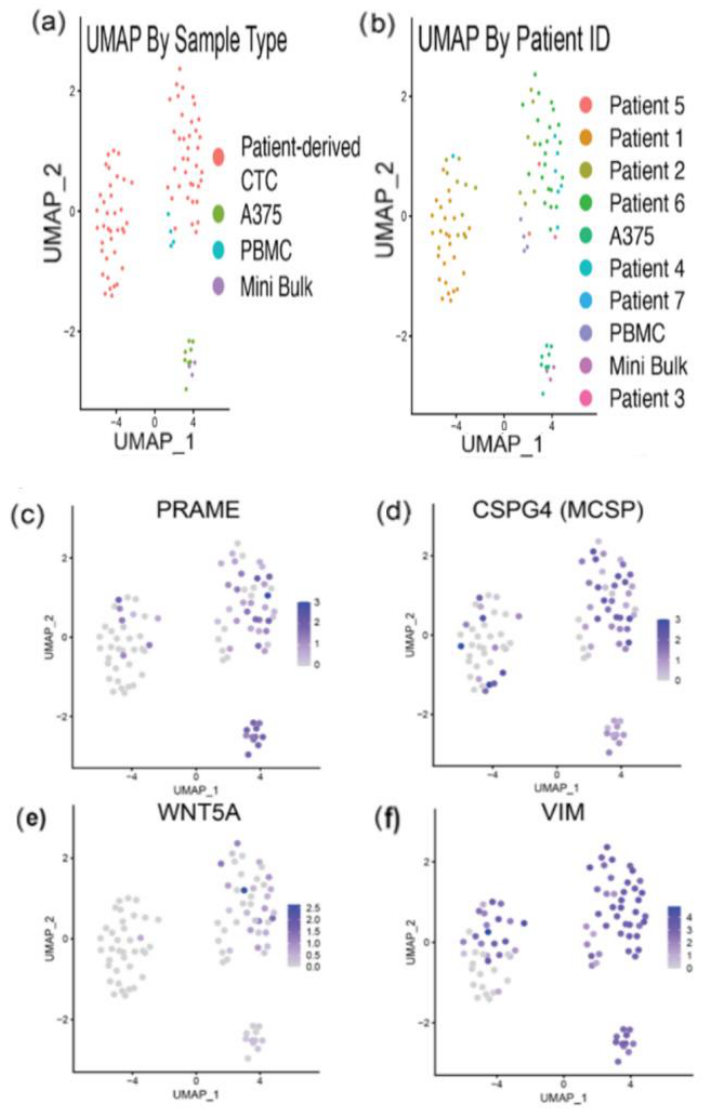
Figure 6. NGS Data Analysis Demonstrates Substantial Cellular Heterogeneity: ( a ) UMAP plot demonstrating clustering of cells colored by cell type. ( b ) UMAP plot demonstrating cell clustering colored by patient ID. ( c – f ) Feature plots of ( c ) PRAME and ( d ) CSPG4 (MCSP) transcript expression demonstrate that some patient-derived CTCs express one, both, or neither of these targets, high- lighting the importance of using multiple markers in a live-cell staining panel for CTC isolation. ( e ) Feature plot of WNT5a expression suggests aggressive, later-stage melanoma cells with a metastatic phenotype may exist among the population. ( f ) Feature plot of VIM expression, demonstrates some patient-derived CTCs may have undergone EMT and switched to an aggressive phenotype.